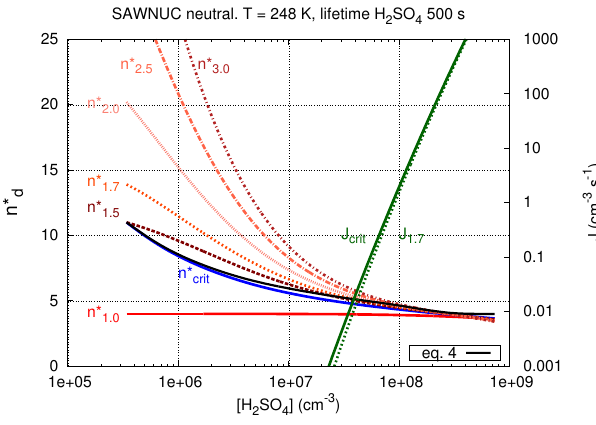
Fig. 1. Examples of the influence of different cut-off diameters on the interpretation of measurements of neutral particle formation rates at T = 248K and H 2 SO 4 lifetime of 500s. Red lines show n ∗ , and the blue lines show n ∗ derived from Eq. ( 3). The black line d shows n ∗ from Eq. (4). The solid green line shows the “true” nucle- ation rate, while the dashed green line shows the formation rate of particles exceeding 1.7nm, i.e. the apparent nucleation rate. Values for both green lines can be taken from the right